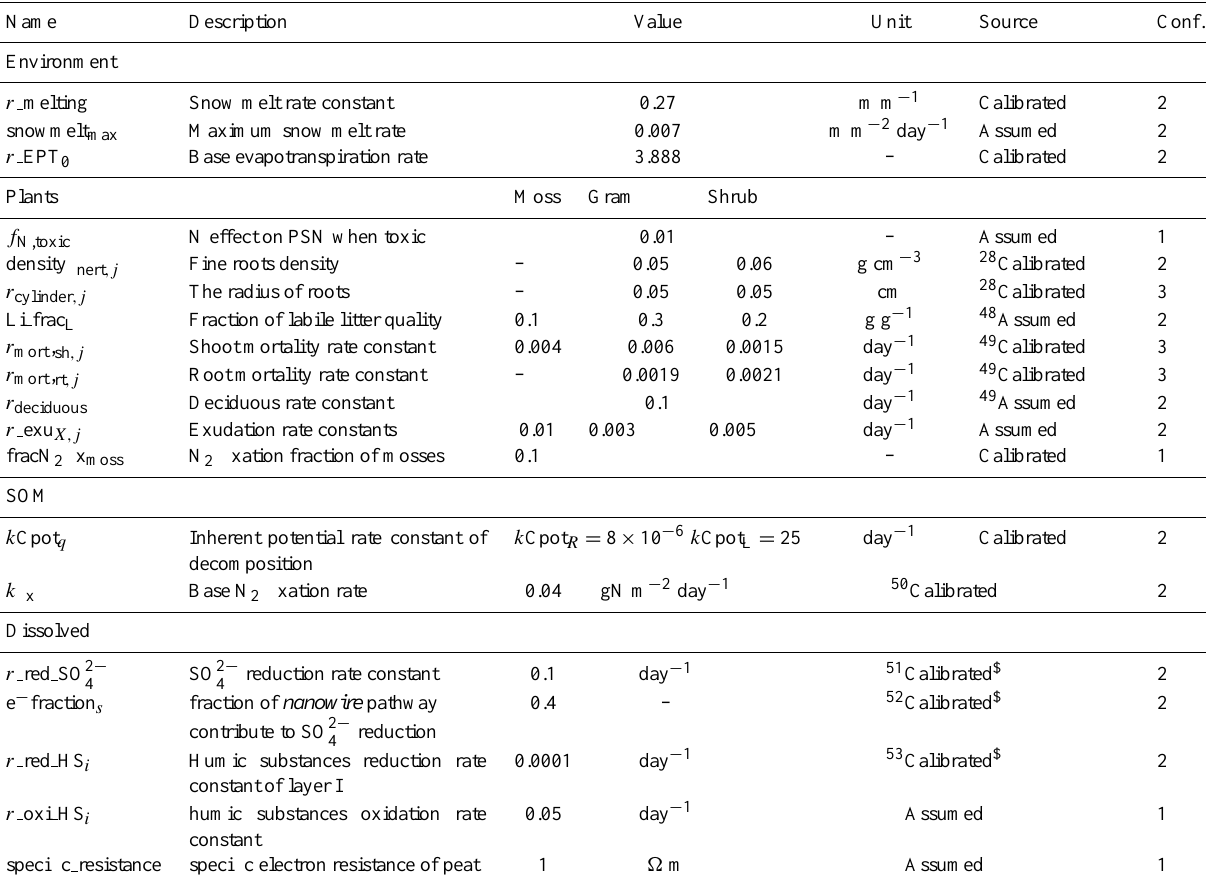
Table 4. Assumed and calibrated